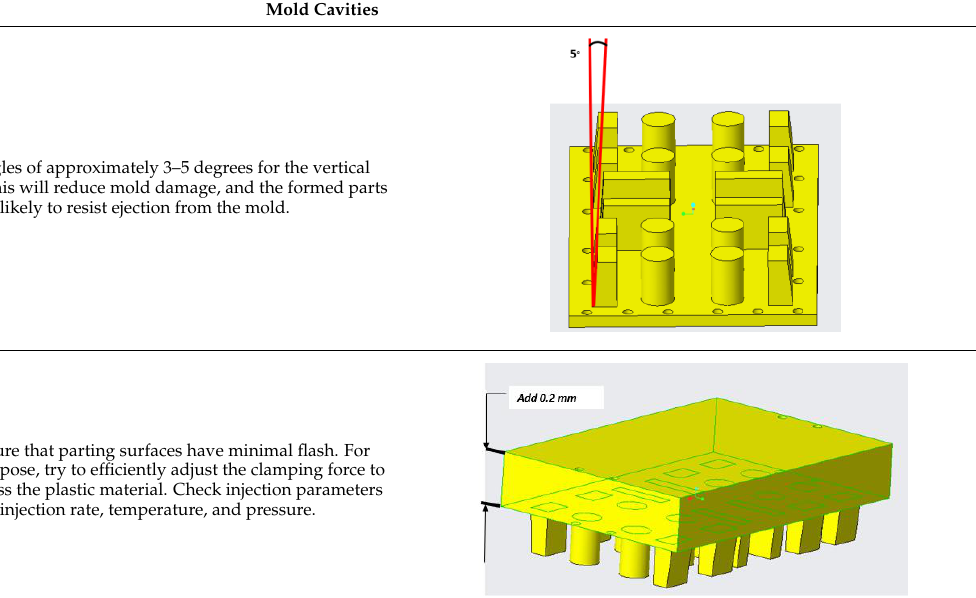
Figure 5. Solid models of cavity insert and cores ( a ) without cooling channels, ( b ) with conventional cooling channels, ( c ) with parallel conformal cooling channels, and ( d ) with series conformal cooling channels.